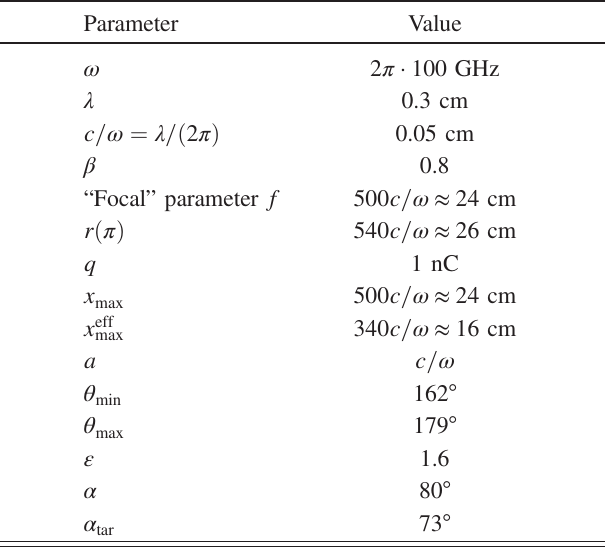
TABLE I. Parameters of numerical